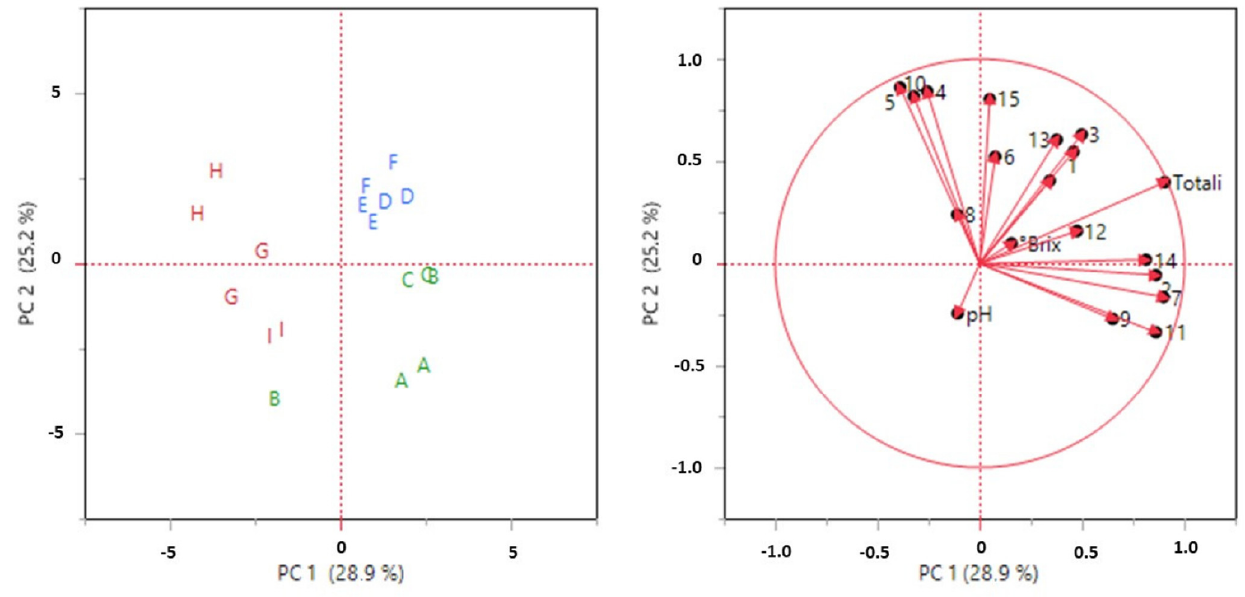
Figure 3. Score and loading plots by PCA on physiochemical and chromatographic results. Green: